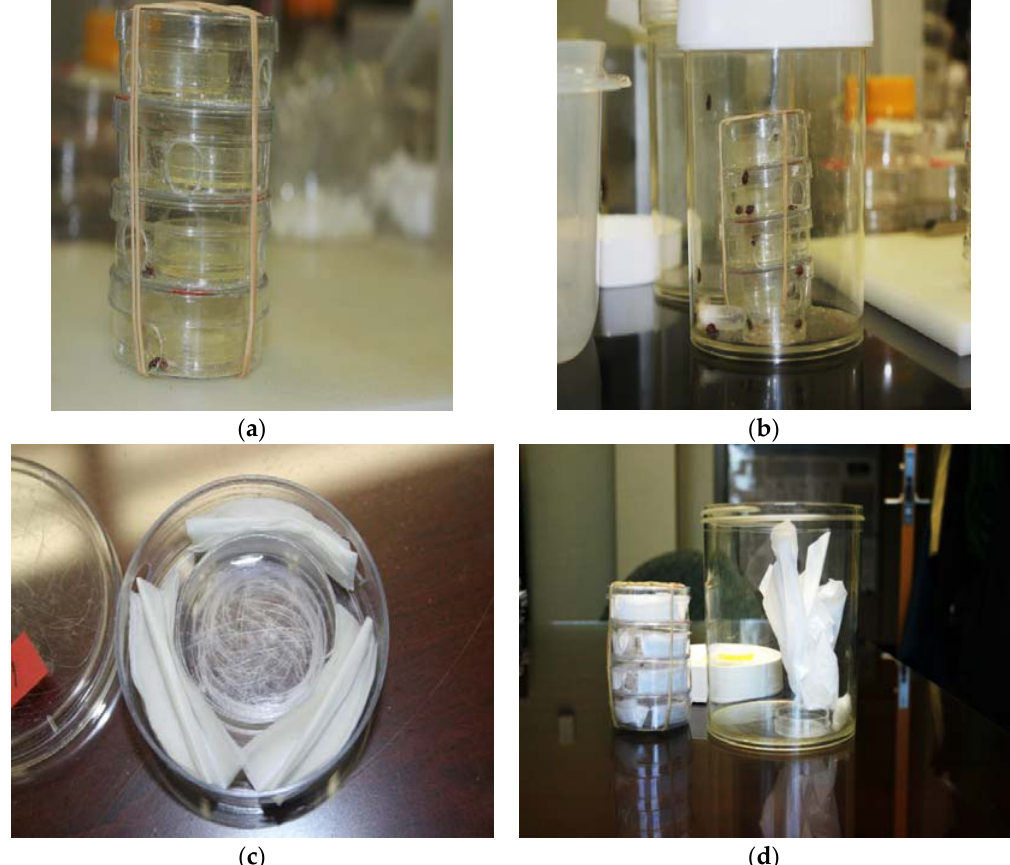
Figure 2. Image of oviposition chamber with chemical dishes containing quercetin powder ( a ), assembled 1 L cage with oviposition chamber, food dish, and water tube ( b ), oviposition unit with empty chemical dish (in center) with folded tissue paper ( c ), and disassembled 1 L cage showing the juxtaposition of lightly crumpled tissue substrate (20 cm × 20 cm sheet) outside the oviposition chamber ( d ). Oviposition chamber consisted of four, stacked units (2 cm high, 6 cm diam each), with a chemical dish (1 cm high, 3.5 cm diam) in the center. Three holes of the same diameter were bored in the walls of each unit to provide easy access to the chemical dish. Cage dimensions were 13 cm × 11 cm (height, diam). When folded, the tissue paper pieces inside a unit were 1.2 cm × 4.0 cm (height, diam).